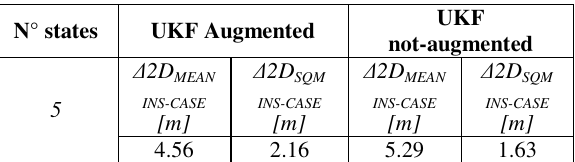
Table 3. Delta mean and delta standard deviation between INS and UKF augmented or not-augmented applied to the motion model with 5 states Figure 9 show the trajectory obtainable by the UKF methods considering the motion model characterized by 5 states: